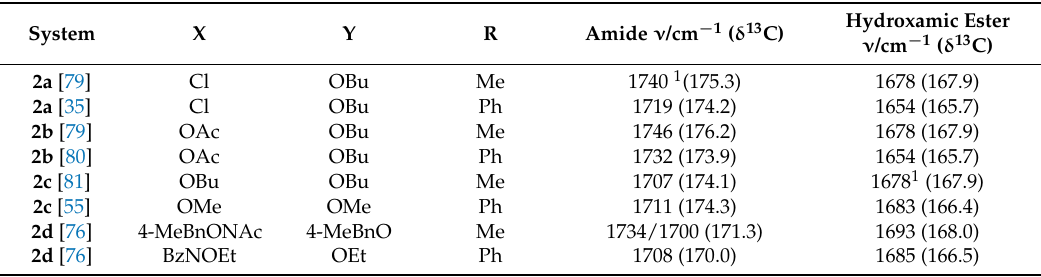
Table 5. Typical spectroscopic data for stable anomeric alkanamides and arylamides (RC(O)NXY), and their hydroxamic ester